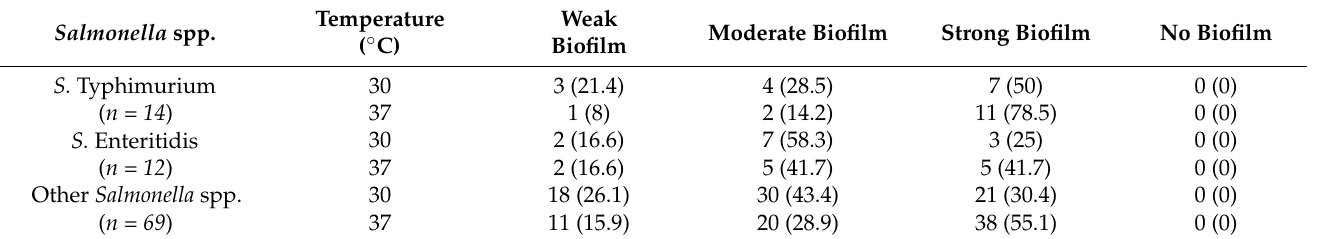
Table 4. Biofilm potential of different Salmonella isolates at different temperatures. Temperature Weak Salmonella spp. Moderate Biofilm Strong Biofilm No ( ◦ C) Biofilm